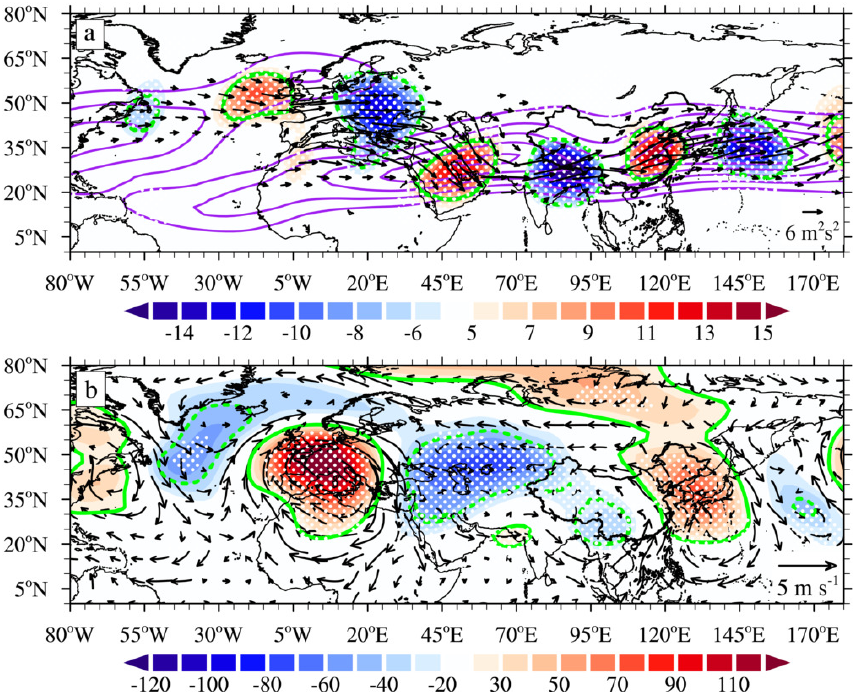
Figure 4. Composite map of (a) 200hPa meridional wind anomalies (shading, unit: ms − 1 , dashed and solid green contours for − 6 and 7ms − 1 , respectively), zonal wind (contours, unit: ms − 1 ), and wave activity flux (vectors, unit: m 2 s − 2 ), (b) 500hPa geopotential height anomalies (shading, unit: gpm, dashed and solid green contours for − 40 and 20gpm, respectively) and 850hPa wind (vectors). Dotted white regions indicate areas at the 99% confidence level based on the two-tailed Student t test.